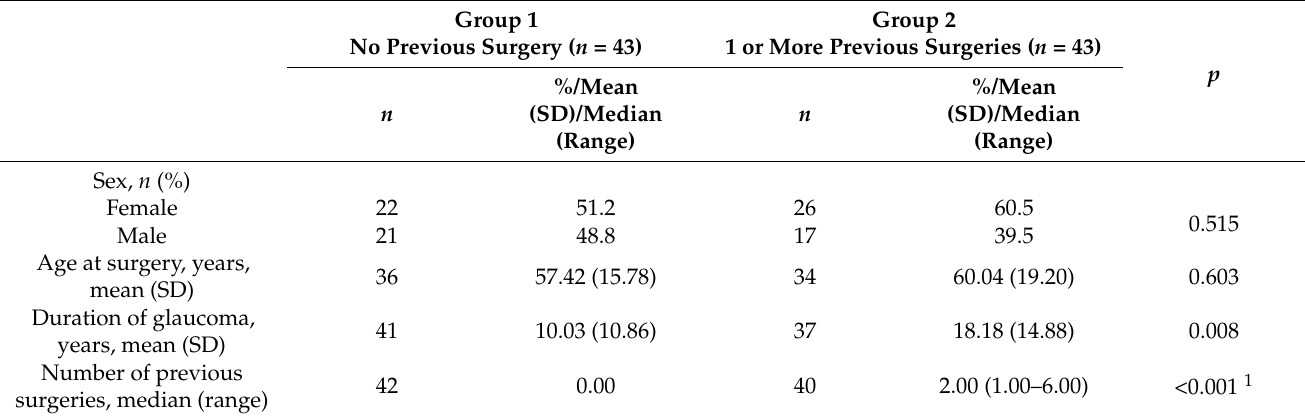
Table 1. Baseline characteristics of the study